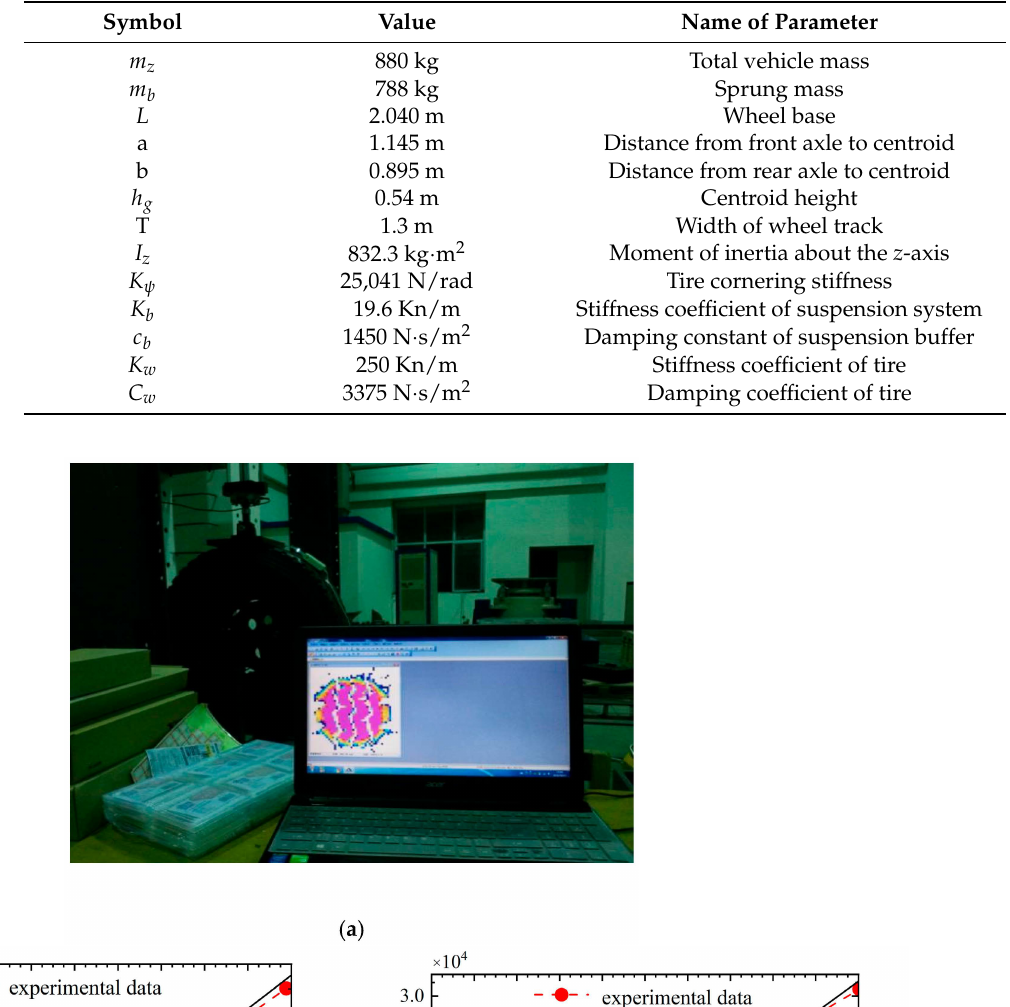
Table 1. Key parameters of the vehicle.